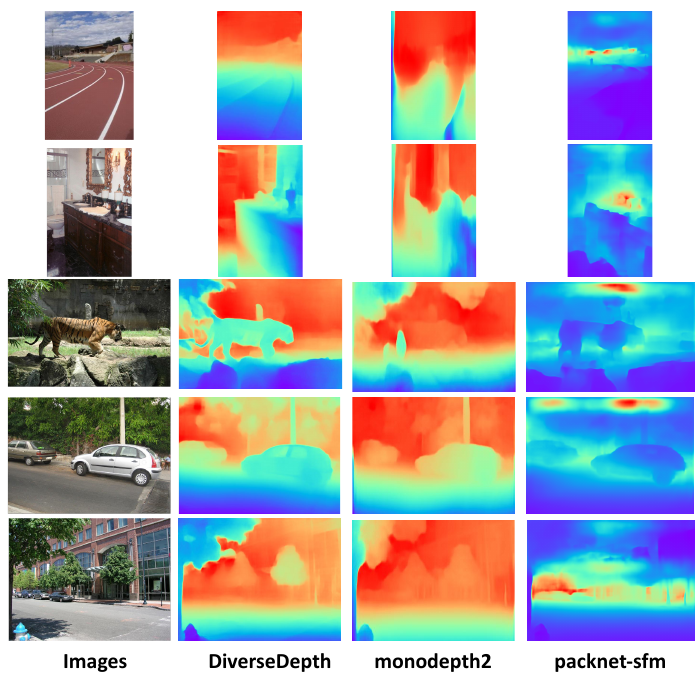
Figure 5. The comparison results of different depth estimation methods on the ADE20k dataset. Because of the lack of the ground truth, we do not retrain depth estimation models. The depth estimation results come from the application of the original models from [21,74,84], respectively. All of the images are not included in the training sets of these three models. The scene in the images includes indoor, outdoor, streetscape, and natural environment. Blue parts mean being closer to the camera, while red regions are